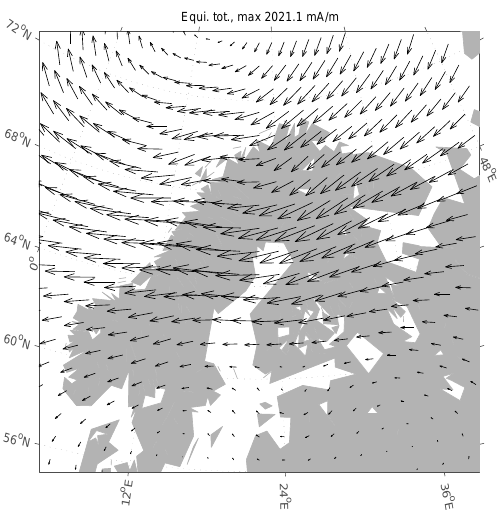
Fig. 10. Log 10 of the relative difference 100 ·| J tot − J ext | / | J ext | . See Figs. 7 −